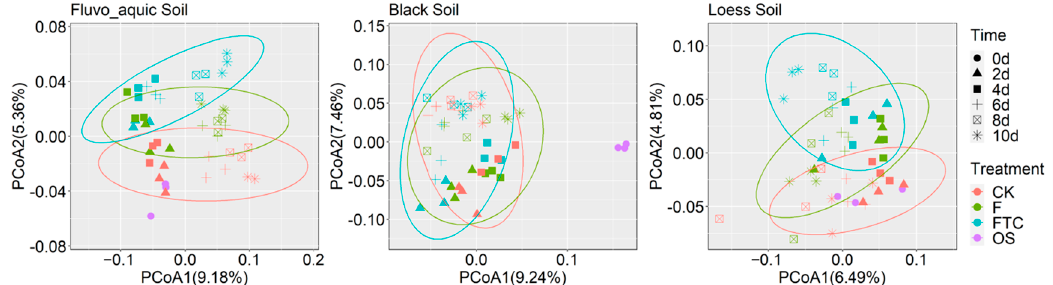
Figure 6. Principal coordinate analysis (PCoA) of fluvo-aquic soil, black soil and loess soil based on the Bray–Curtis distance showing the profile of the bacterial community structure under the FTC, F and CK treatments at different incubation times; CK: control treatment (10 °C); F: freezing treatment ( − 10 °C); FTC: freeze–thaw cycles ( − 10/10 °C); OS, original soil.